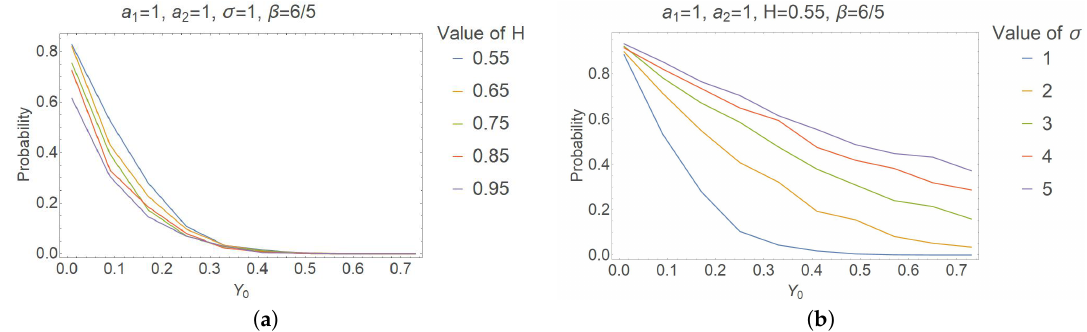
Figure 2. Probability that the trajectories have negative values: ( a ) Dependence of probability on Y 0 for different H . ( b ) Dependence of probability on Y 0 for different σ